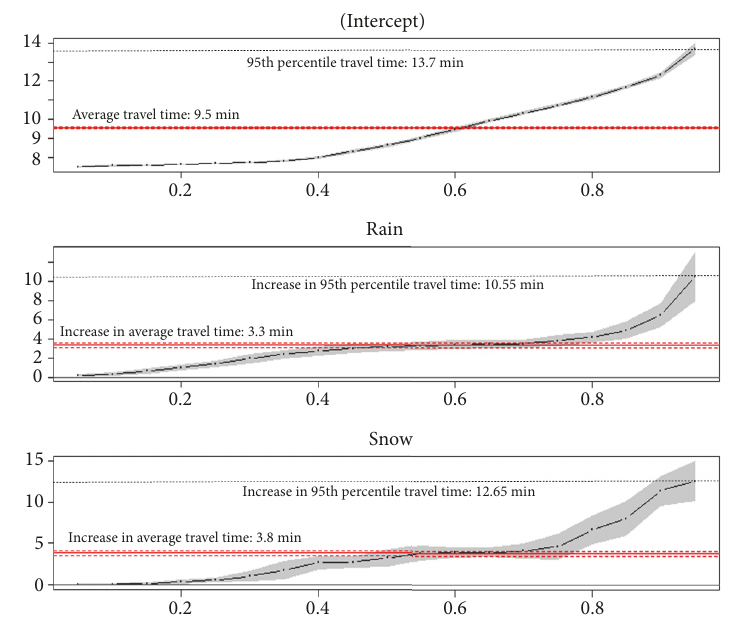
Figure 3: Regression results.